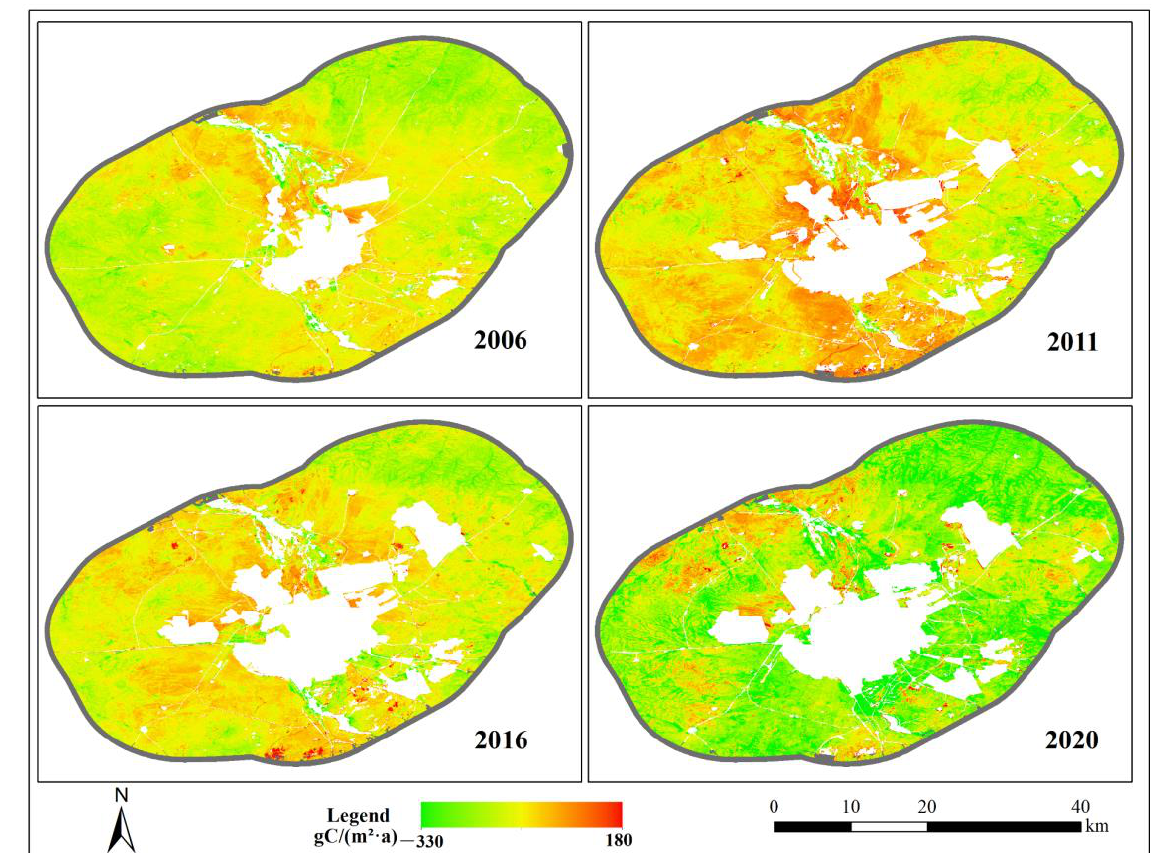
Figure 6. Spatial distribution of NPP induced by human activities in the experimental years.